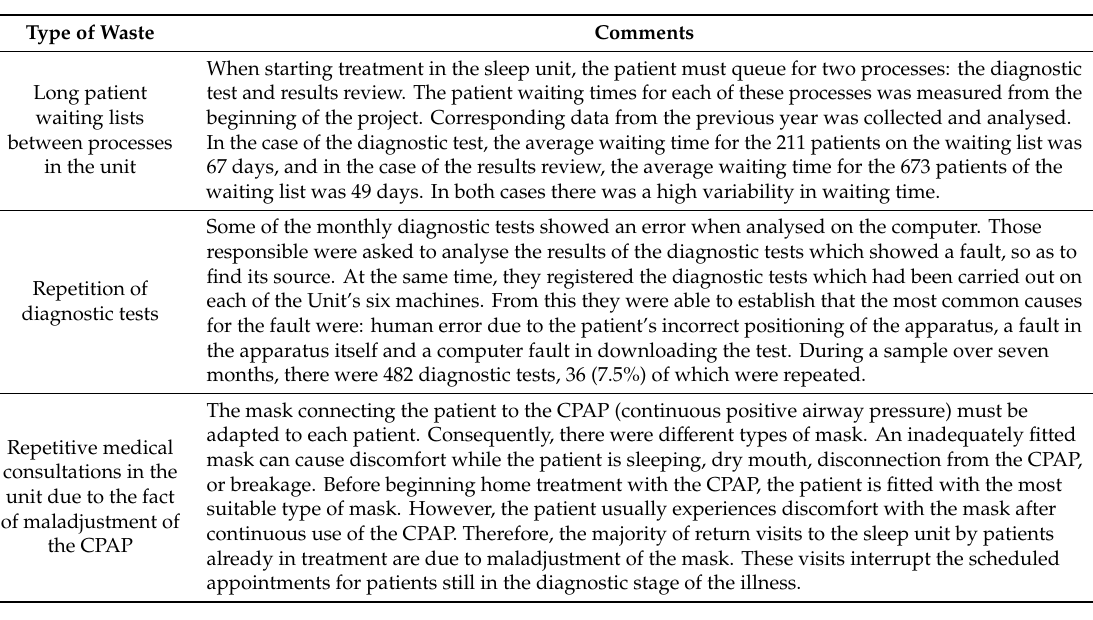
Table 1. Waste with direct impact on the patient.